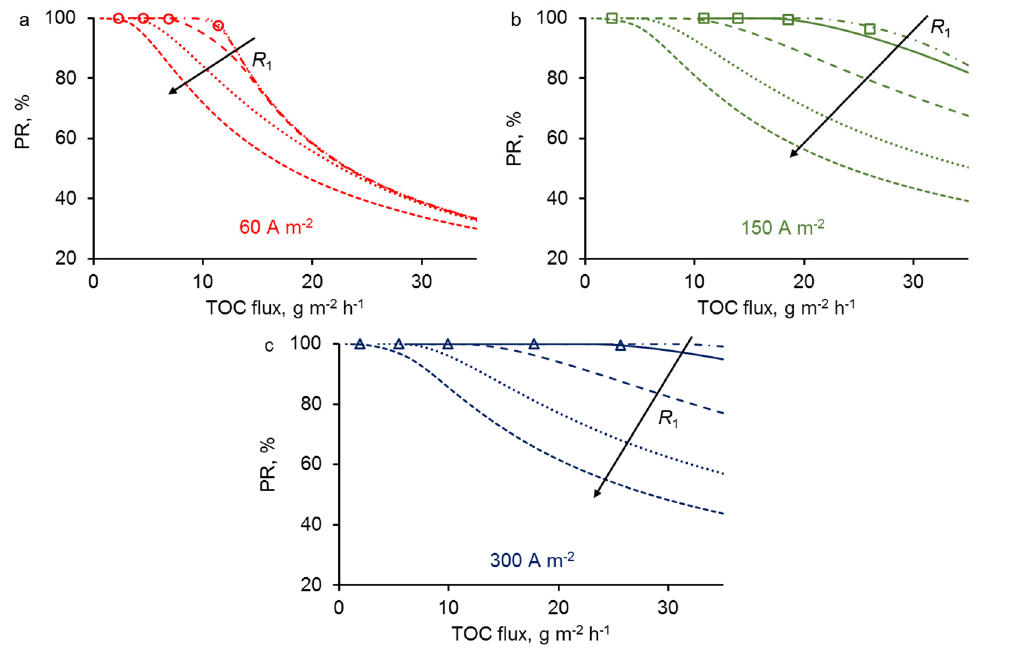
Figure 6. The influence of pore radii on the PR of the PCT at fixed porous fraction ε = 0.2 and j = 60 ( a ), 150 ( b ) and 300 ( c ) A · m − 2 . The current density is mentioned in each figure. The arrow represents an increment of pore radius: R 1 = 0.5, 0.7, 1.5, 3 and 5 µ m. All other parameters are presented in Table